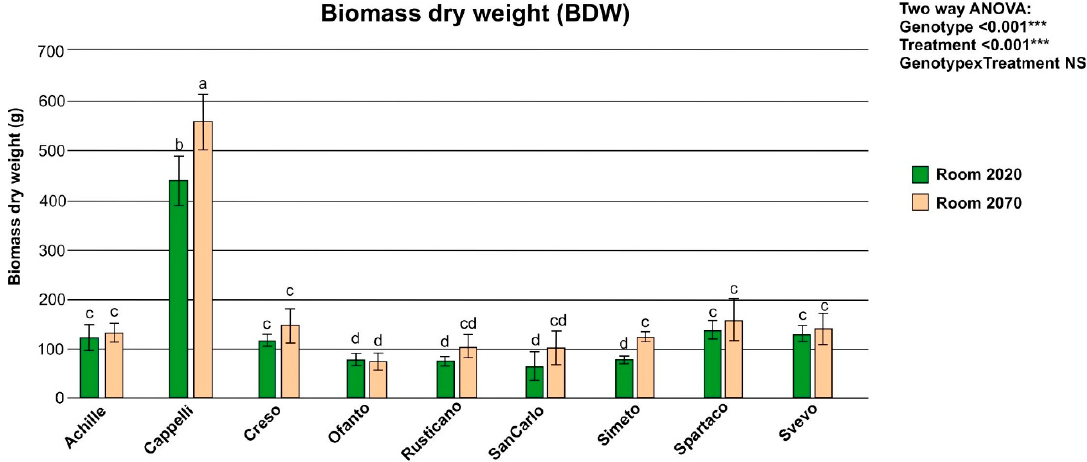
Figure 3. Total biomass dry weight (BDW) values per pot of the individual varieties grown in “room 2020” and in “room 2070”. Each biological replicate had three seedlings per pot. Top right: Two-way ANOVA results (NS: not significant; *** p < 0.001). Letters (a), (b), (c), and (d) refer to significantly di ff erent means across the genotypes and the treatment (Tukey-HSD post hoc test, p <